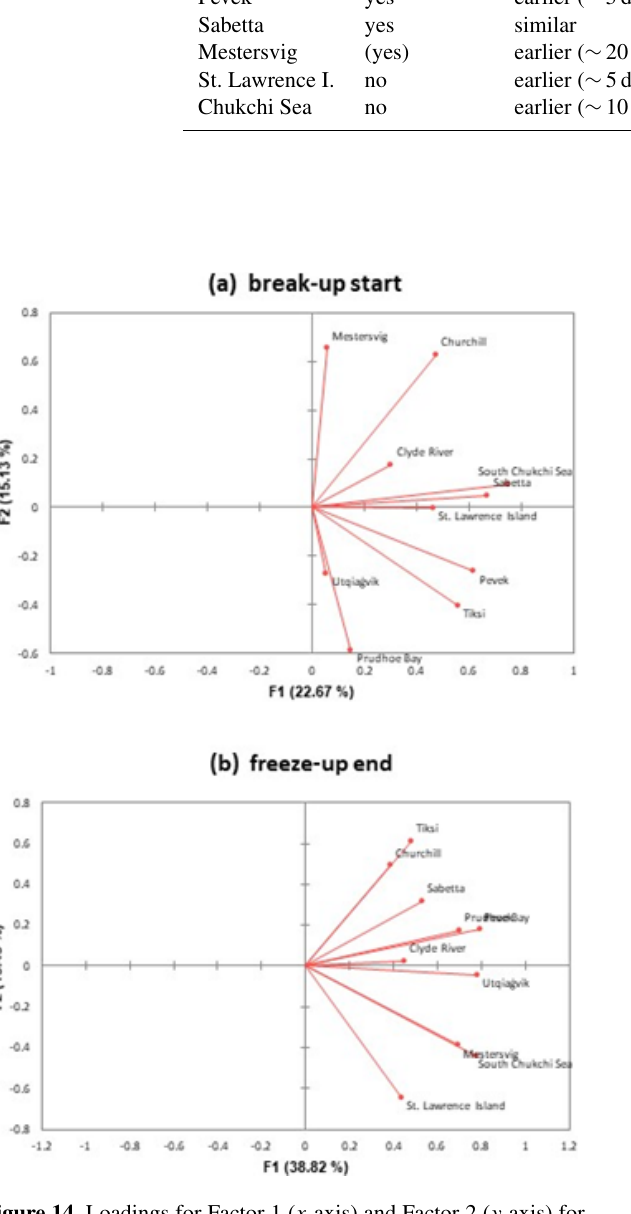
Figure 14. Loadings for Factor 1 ( x axis) and Factor 2 ( y axis) for (a) the start of breakup and (b) the end of freeze-up at the 10 local coastal sites. Labels on vectors denote